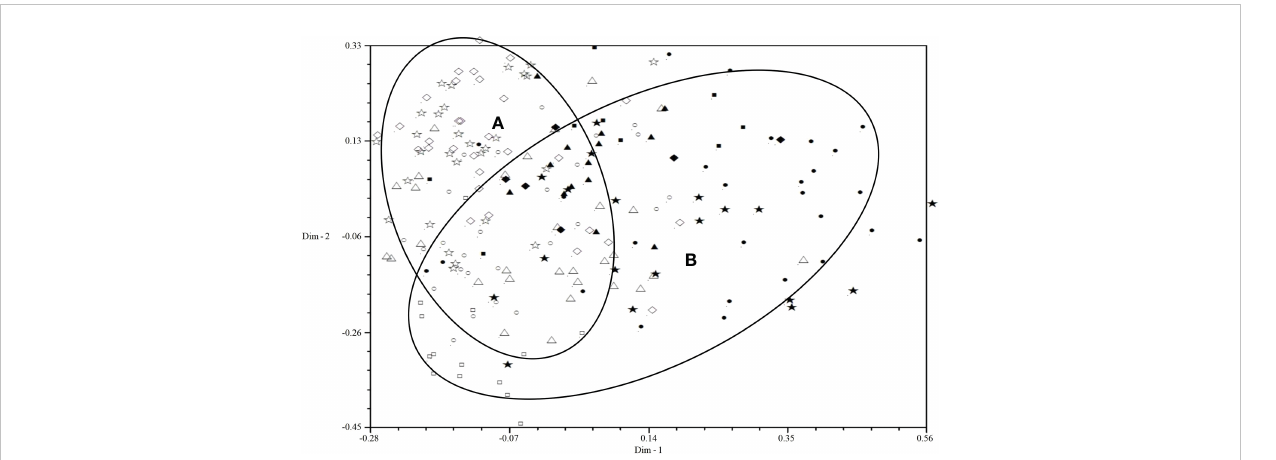
FIGURE 3 Two-dimensional plot of principal coordinates analysis of Puccinia triticina based on virulence polymorphism. ◼ , Year 2001; ▲ , Year 2002; ◆ , Year 2003; (cid:129) , Year 2004; ★ , Year 2005; □ , Year 2006; ○ , Year 2007; △ , Year 2008; ◇ , Year 2009; ☆ , Year 2010. Area A contains most isolates from 2007-2010 and area B contains most isolates from 2001-2006.